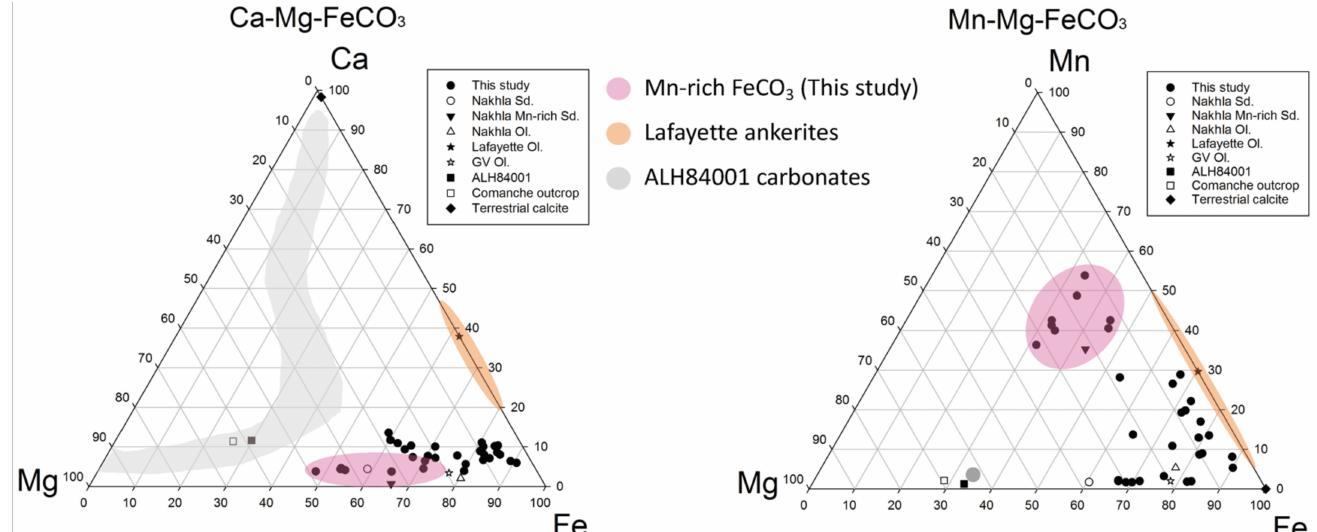
Figure 3. Identification of siderite and Mn-rich siderite in the carbonate based on Table S2. Triangular diagram plotting the cationic composition of carbonates using the results of Ca, Mg, Mn, and Fe concentrations in iddingsite quantified by FE-EPMA (analysis spots are shown in Figure S1). The number of analyzed points is